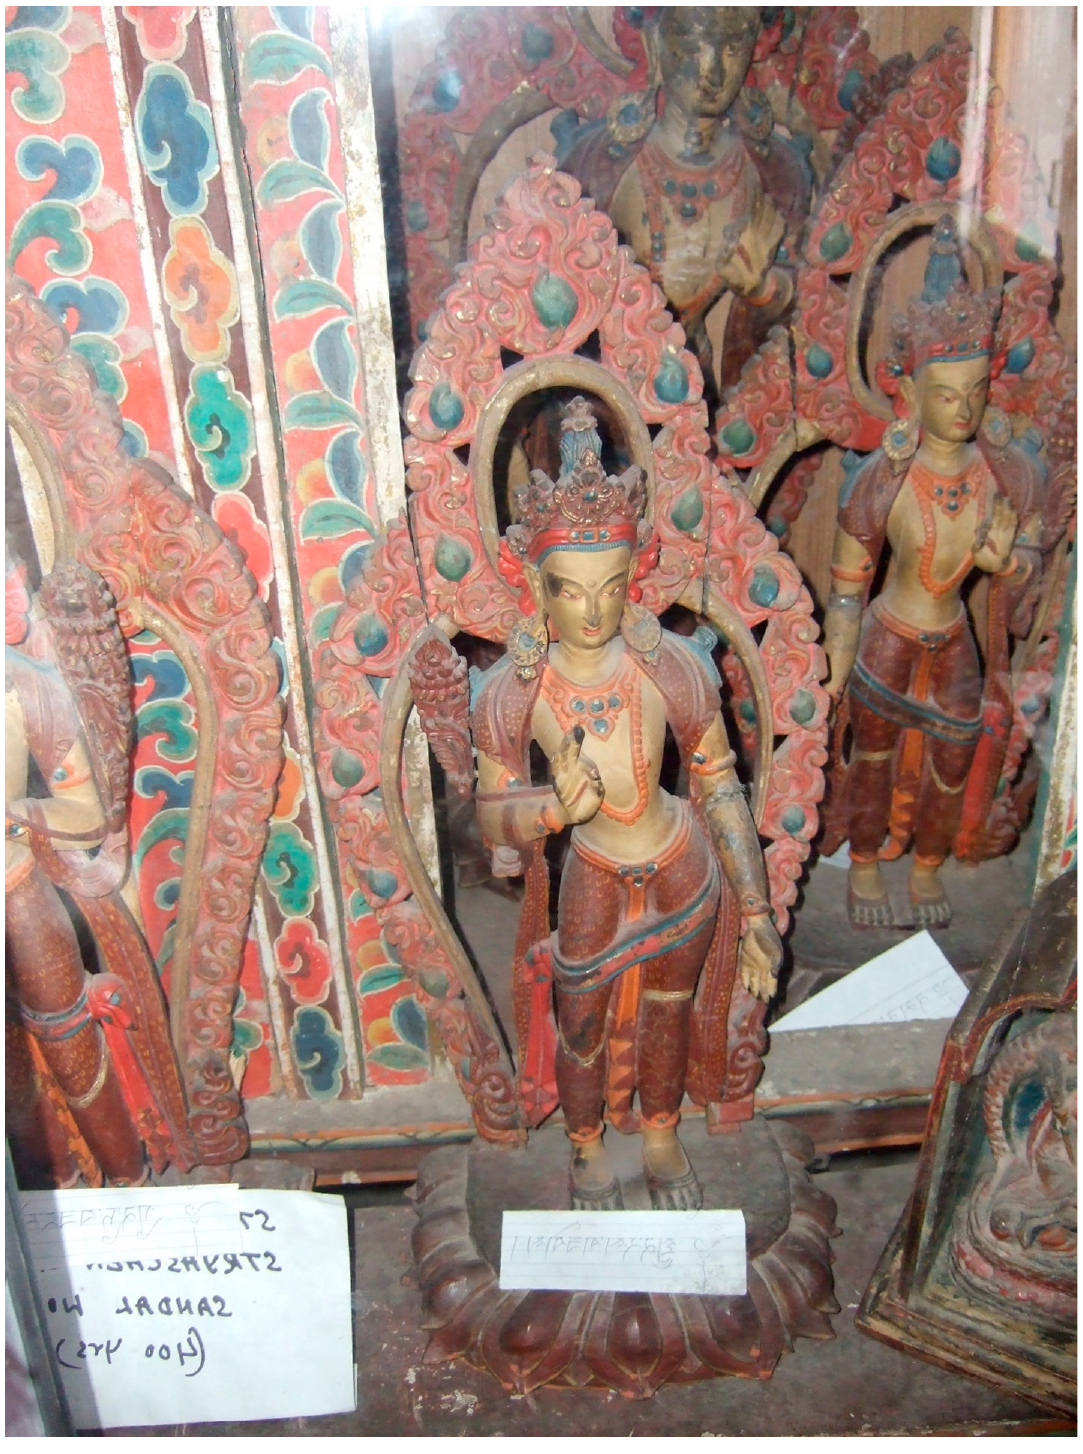
Figure 11. Shrine with wooden statues, Stakna Monastery, Ladakh (photo C. Bellini 2011).